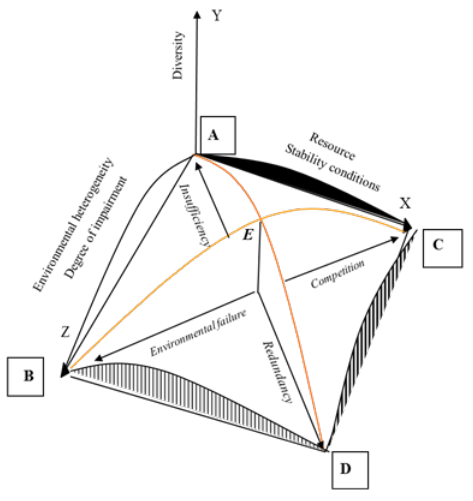
Figure 2. Model of change of diversity, expressed by Shannon indices (Y), in gradients of resource abundance and sustainability of environmental conditions (X), degree of disturbance and heterogeneity of the environment (Z) (according to [5]).